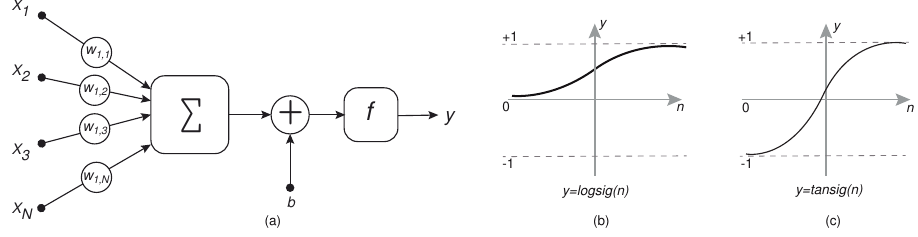
Figure 2. ( a ) Single-layer network and transfer functions; ( b ) log-sigmoid, and ( c ) hyperbolic